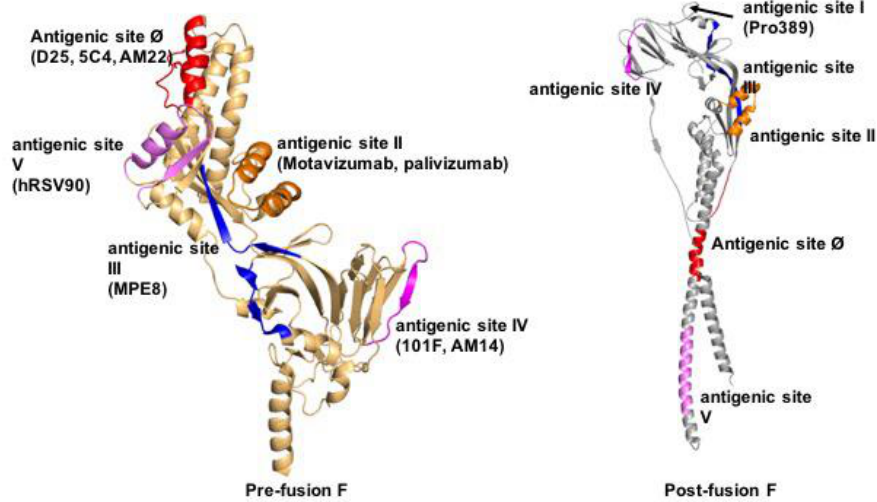
Figure 4. Defined antigenic epitopes in pre- (left) and/or postfusion (right) RSV F. Shown are antigenic sites Ø and I-V. Sites Ø and V are prefusion F-specific, sites II-IV are present in both pre- and postfusion F, and site I is formed in postfusion F only. Ribbon representations of single RSV F monomers are shown for clarity, residues forming the individual epitopes are highlighted.